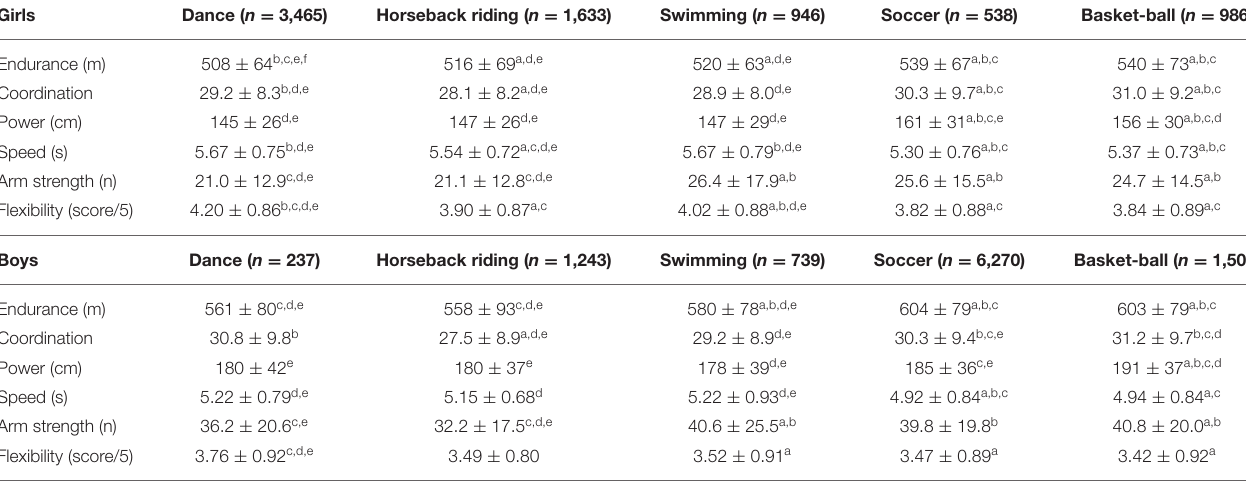
TABLE 4 | Performances during the tests of physical fitness according to sport in girls and boys.